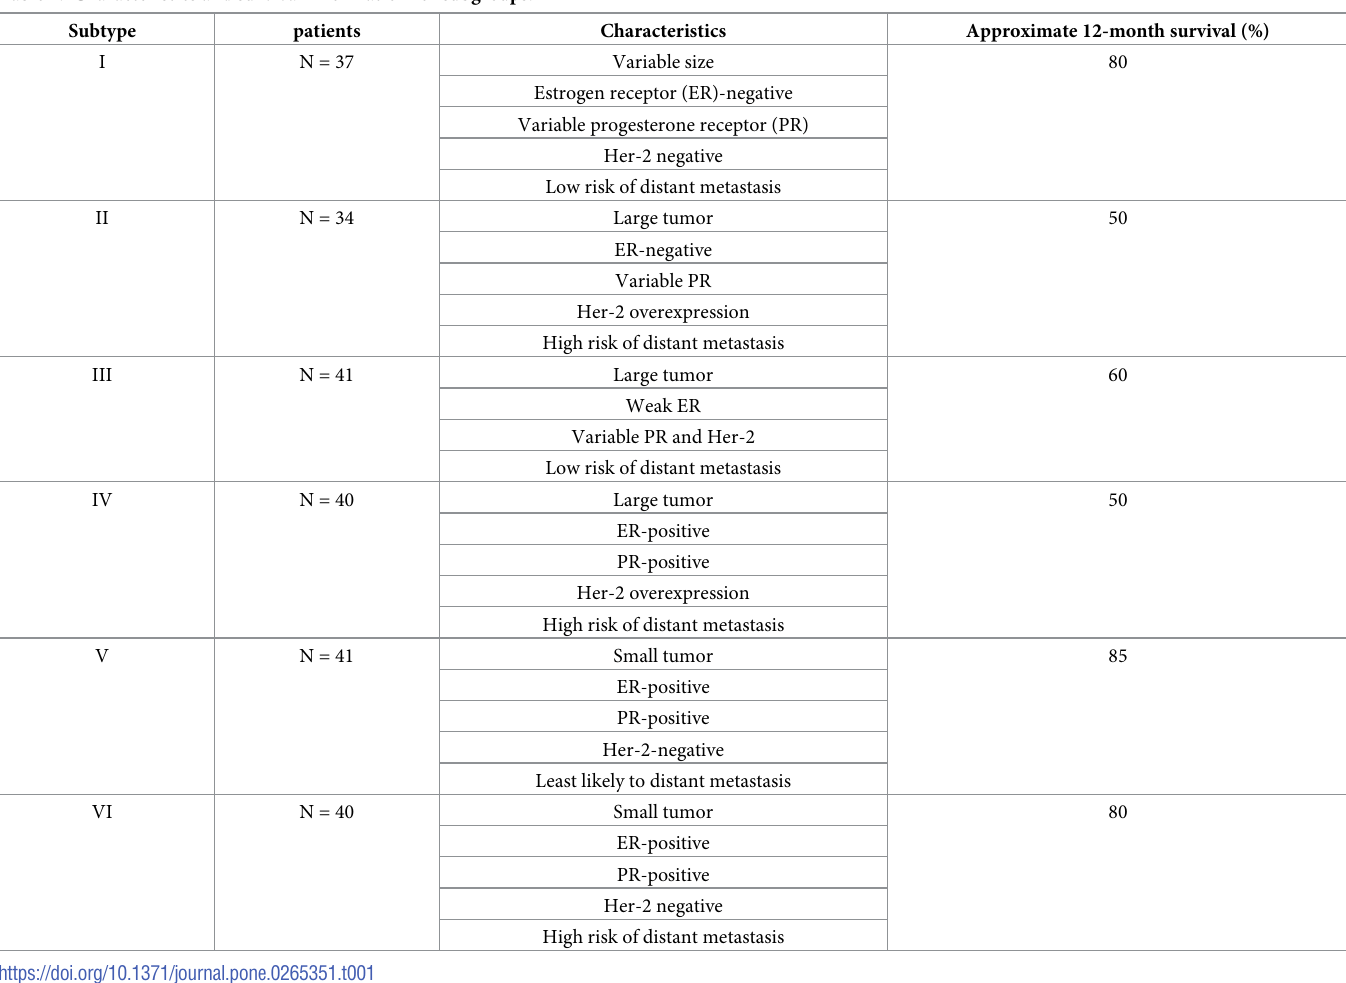
Table 1. Characteristics and survival information for